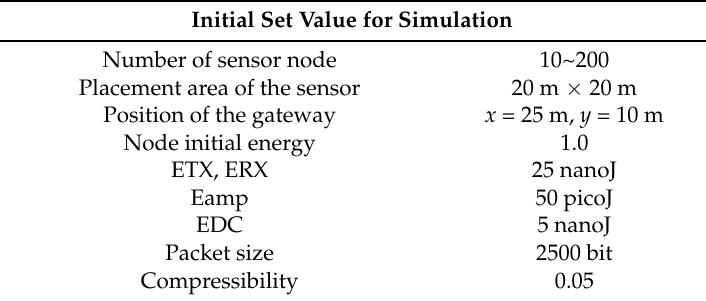
Table 2. Initial simulation setup